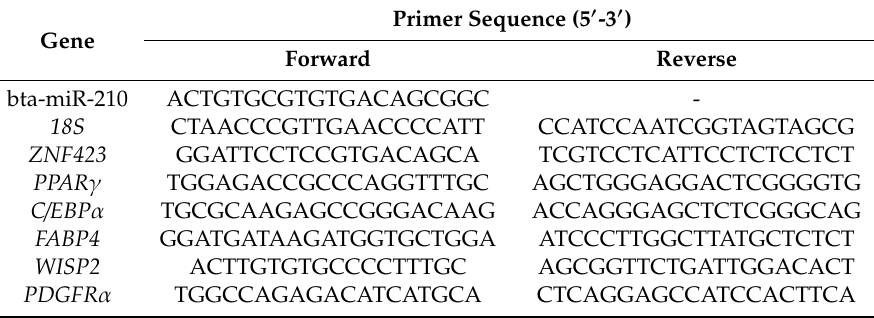
Table 1. Sequences of primers used for